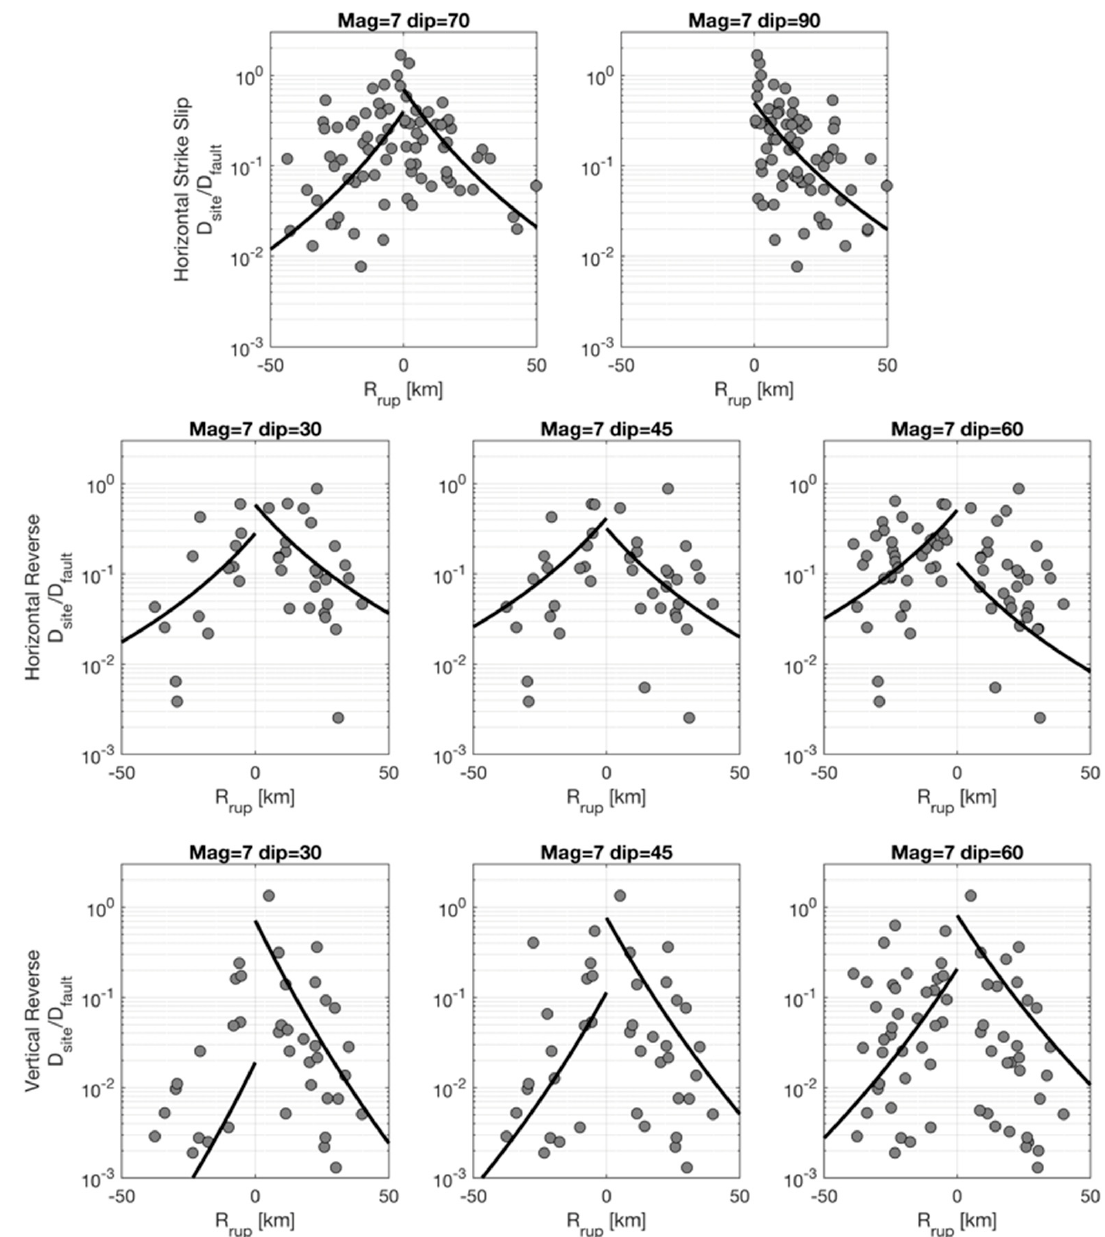
Figure 9. Comparison between fling-step amplitude (D site ) normalized by the average slip over the fault rupture (D fault ) versus R rup from the Kamai et al. (2014) [8] attenuation model (black lines) and eBASCO (grey circles), for Mw 7.0, showing the ( top ) horizontal strike slip, ( middle ) horizontal reverse, and ( bottom ) absolute values of the vertical reverse. eBASCO amplitudes are for the maximum horizontal final displacement of the rotated waveforms (RotD100).